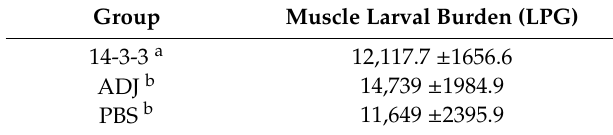
Table 1. T. britovi muscle larvae (ML) recovered from infected mice by HCl-pepsin